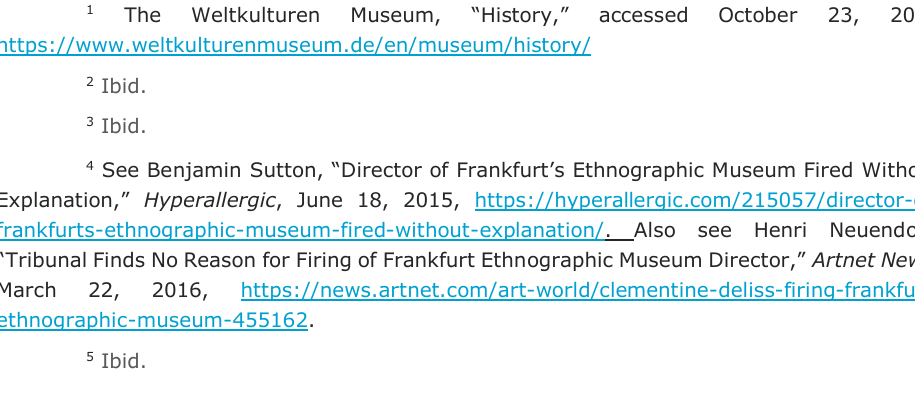
Contemporaneity: Historical Presence in Visual Culture